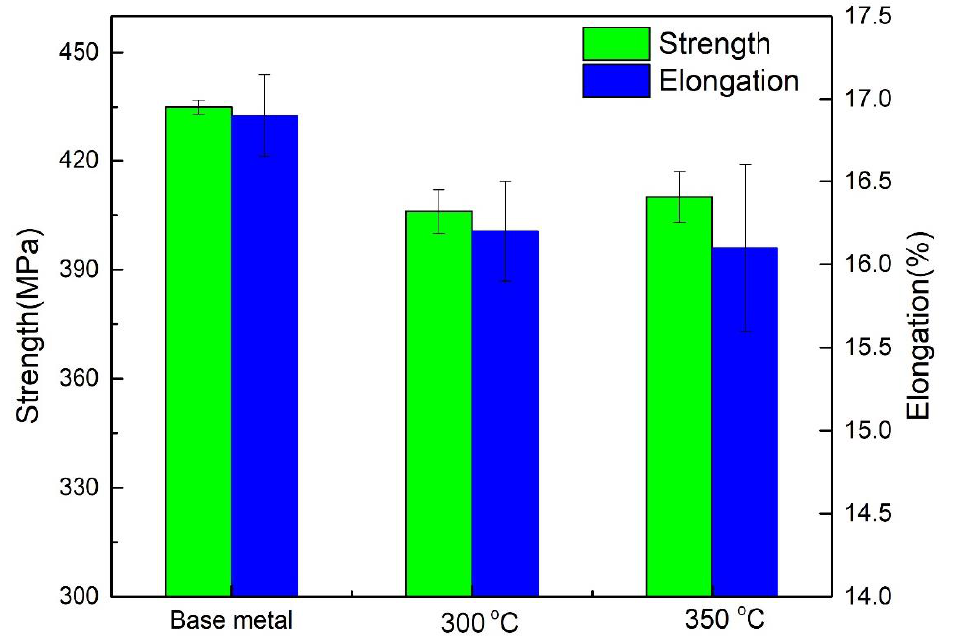
Figure 4. The mechanical properties of 7N01 aluminum alloy with different thermal cycling conditions.